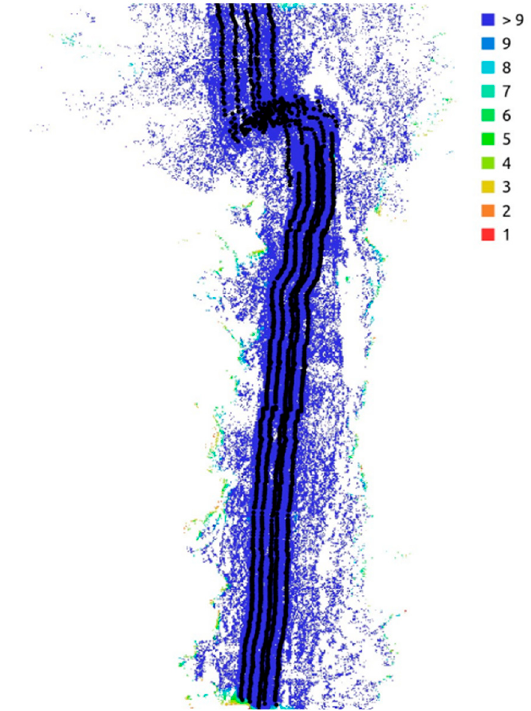
Figure 6. Ground coverage and the number of images per point.